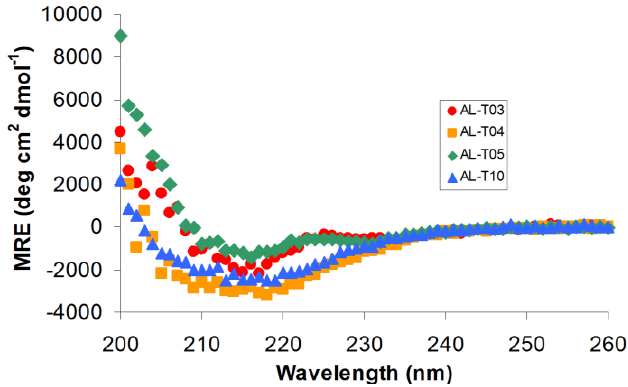
Figure 2. Far UV CD spectra of AL proteins characterized in this study. The experiments were performed in 10 mM Tris–HCl pH 7.4 at 4 °C. The minimum mean residue ellipticity (MRE) at 217 nm indicates that the proteins adopt the expected β-sheet structure typical of immunoglobulin